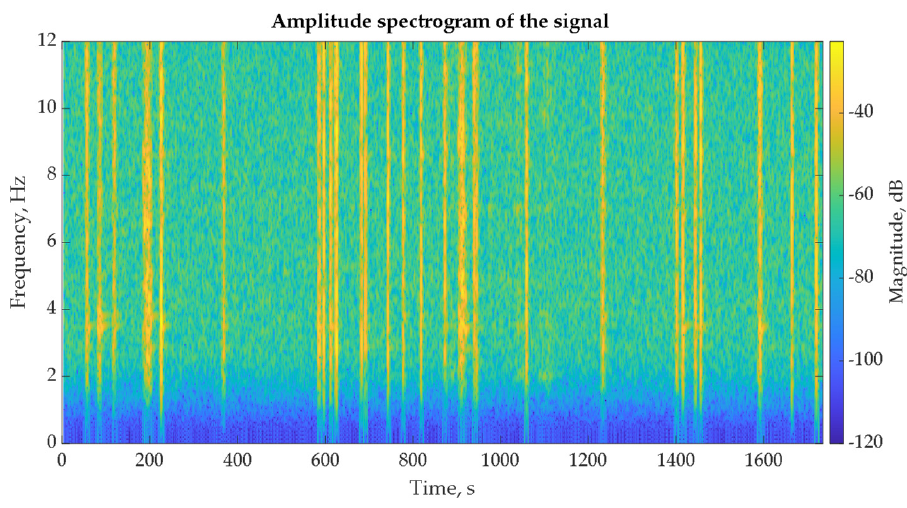
Figure 14. Short Time Fourier Spectrum of sensor 2 at transverse axis (Y axis).